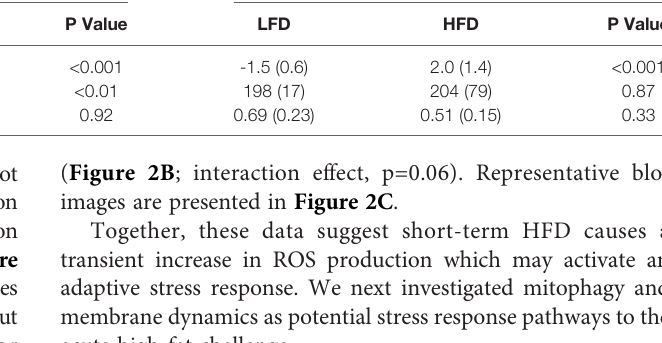
TABLE 1 | Mice characteristics after short-term high-fat diet. P values are from un-paired t-tests for low-fat diet (LFD) compared to high-fat diet (HFD). Data are mean (SD) with n = 5 per diet